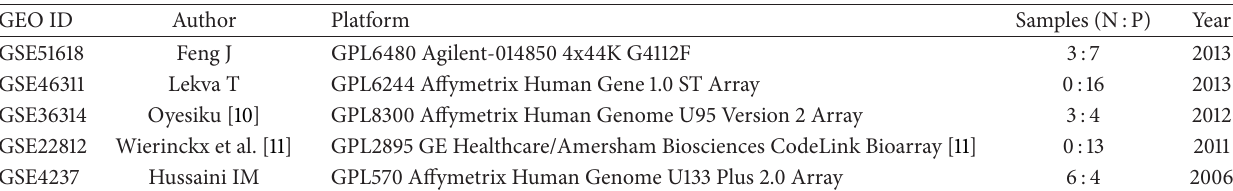
Table 1: Characteristics of the individual